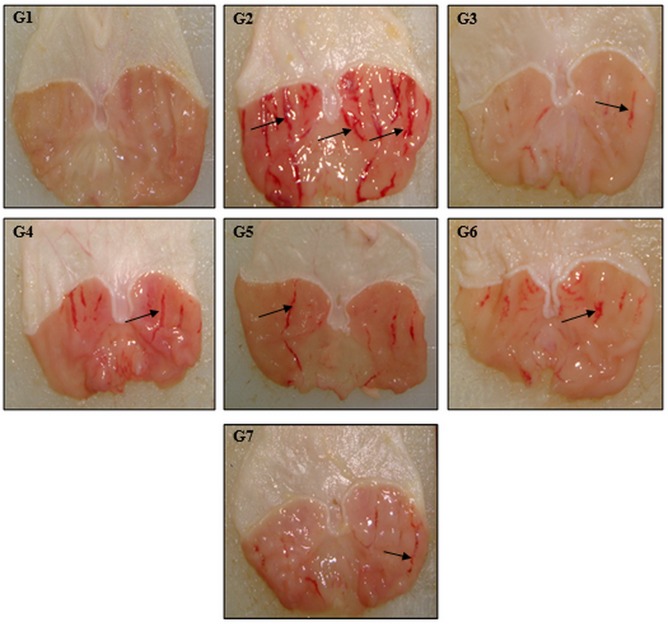
Macroscopic appearance evaluation of gastric mucosa.(G1) (Normal control group); (G2) (Ulcer control group); (G3) (Omeprazole); (G4) (62.5 mg/kg), (G5) (125 mg/kg), (G6) (250 mg/kg) and (G7) (500 mg/kg) V. pubescens extract. Black arrow indicates hemorrhagic injury. There were 6 rats in each group of experiment.